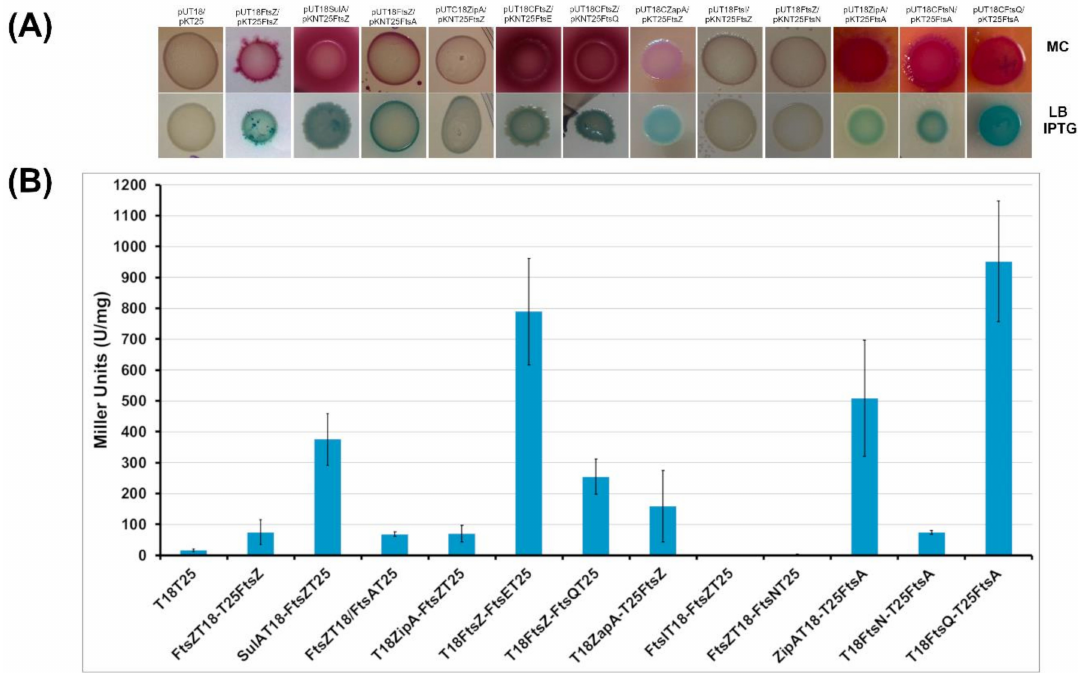
Figure 5. BACTH analysis of interactions between Fts proteins. ( A ) Escherichia coli strain BTH101 was co-transformed with two-hybrid vector plasmids (Table S3) expressing di ff erent hybrid proteins, as indicated. Transformants were spotted onto nutrient agar plates containing IPTG (LB IPTG) and X-Gal, or on MacConkey agar plates (MC) and incubated at 30 ◦ C for 40 h. Blue coloration on LB IPTG or pink coloration on MC indicates a positive interaction. ( B ) The e ffi ciencies of functional complementation between the indicated hybrid proteins were quantified by measuring β -galactosidase (expressed in Miller Units) activities in suspensions of E. coli BTH101 cells harboring the corresponding plasmids, as described in Materials and Methods. Each bar represents the mean value from results of at least three independent cultures. The E. coli BTH101 harboring the empty vectors was used as